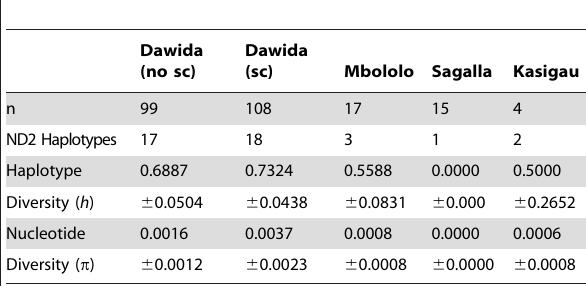
Table 1. Haplotype and nucleotide diversity for populations of Kinyongia boehmei from the Taita